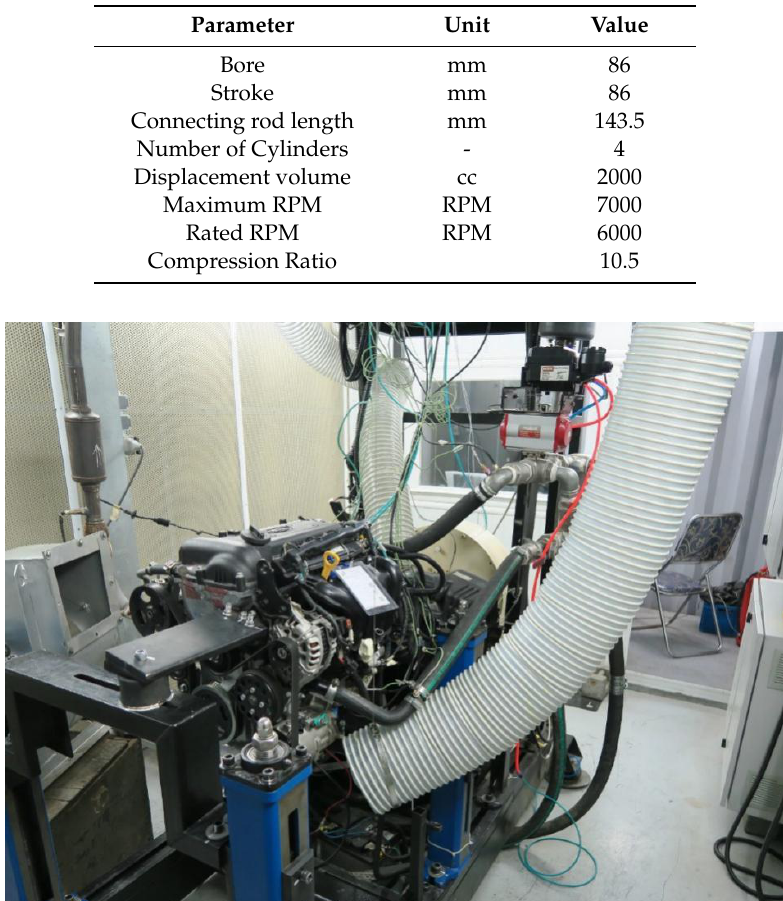
Table 1. Technical specifications of KIA Cerato engine.